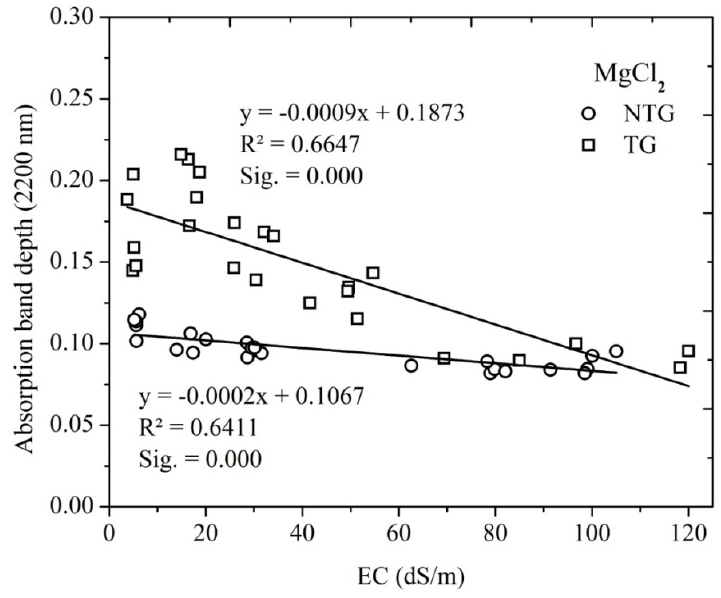
Figure 13. Relationship between the depth of the 2200 nm clay mineral absorption band and electrical conductivity (EC) for MgCl salinization for NTG and TG 2